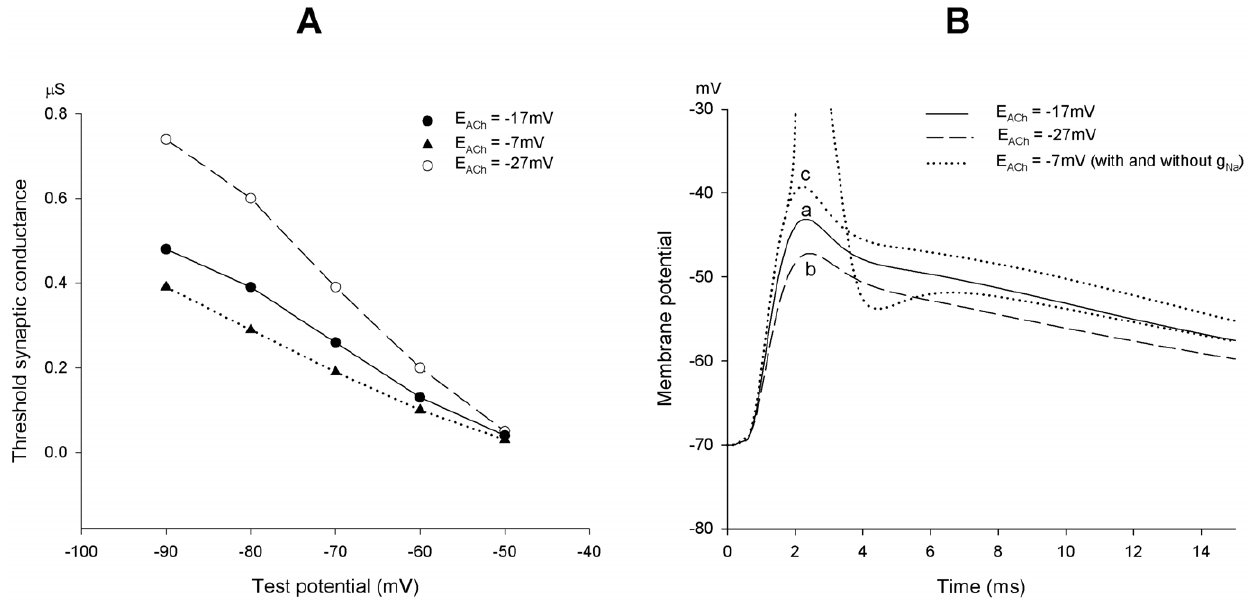
Figure 6. Neuron excitability is regulated by shifts of the EPSC null potential. ( A ). Calculation of the threshold synaptic conductance required to fire the ideal sympathetic neuron held at different membrane potential levels ( 2 50/ 2 90 mV range); 6 10 mV changes in E ACh from the normal 2 17 mV mean value are considered. ( B ). Simulation of the EPSP generated in the model neuron held at 2 70 mV by a just subthreshold synaptic conductance (0.27 m S), with E ACh = 2 17 mV (a). The effects of the same value of synaptic conductance are examined with the value of E ACh moved to 2 27 mV (b) or to 2 7 mV (c). The synaptic response is larger in (c) and, if active voltage-dependent sodium conductance (g Na ) is present, the synaptic input results adequate to fire the neuron, otherwise silent.